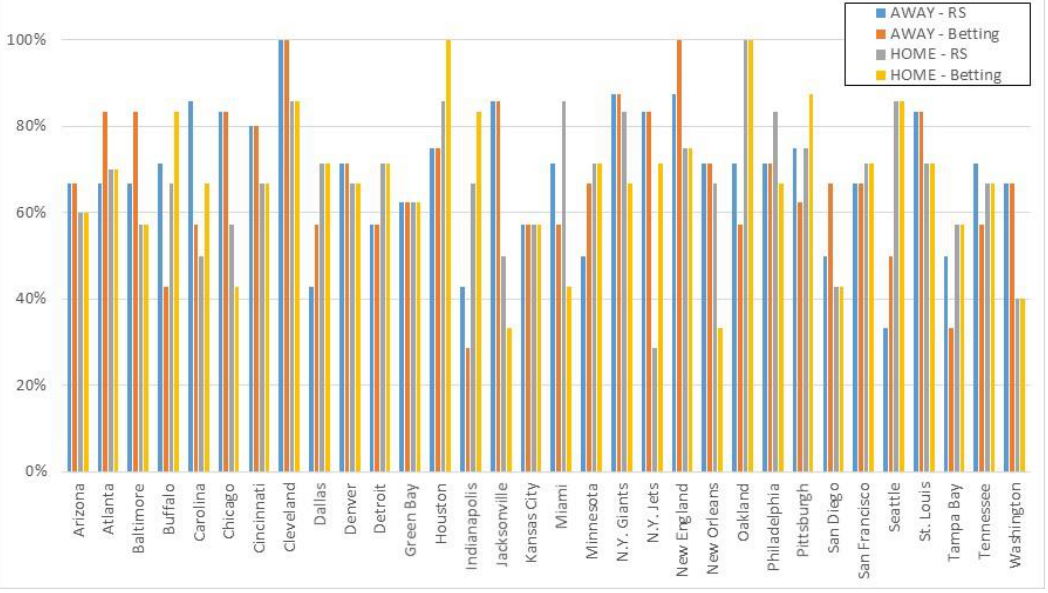
Figure 6. Comparison of accuracy and field for each team.